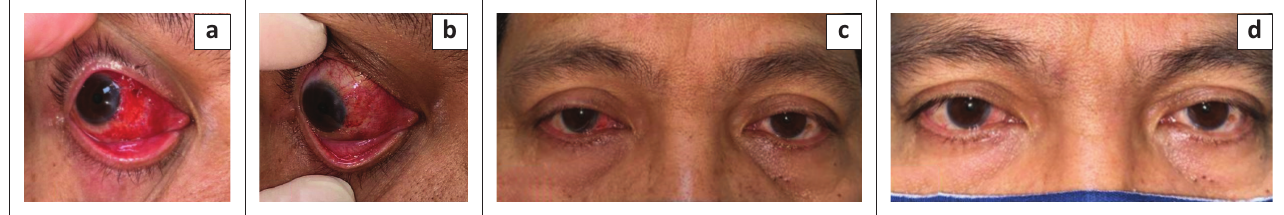
FIGURE 1: Treated pterygium (left eye) showing: (a) 1-month postoperative with mild nasal conjunctival hyperemia and a dot of subconjunctival hemorrhage. (b) At the end of follow-up with normal conjunctival vasculature in the nasal quadrant. a b c d